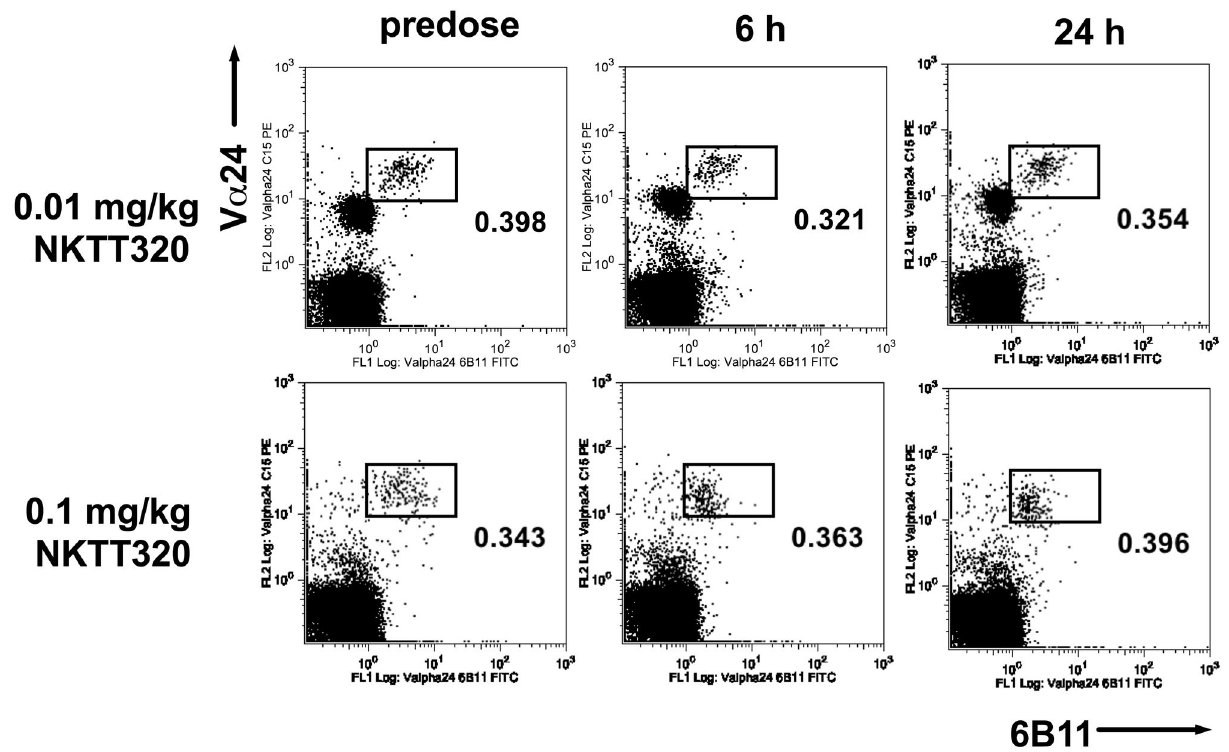
Figure 5. Cynomolgus macaques in a dose-range finding study (n=1 per dose) were dosed with a single dose of 0.01 mg/kg and 0.1 mg/kg NKTT320, respectively and subsequently bled at indicated timepoints. Whole blood samples were stained with antibodies against CD3 (SP34.2), CD20 (2H7), TCR Vα24 (C15), CD159a (Z199) and invariant TCR (6B11). Red blood cells were subsequenltly lysed, cells washed and analyzed by flow cytometry. iNKT cells were identified as CD3+, Vα24+ and 6B11+ lymphocytes and reported as % of CD3+